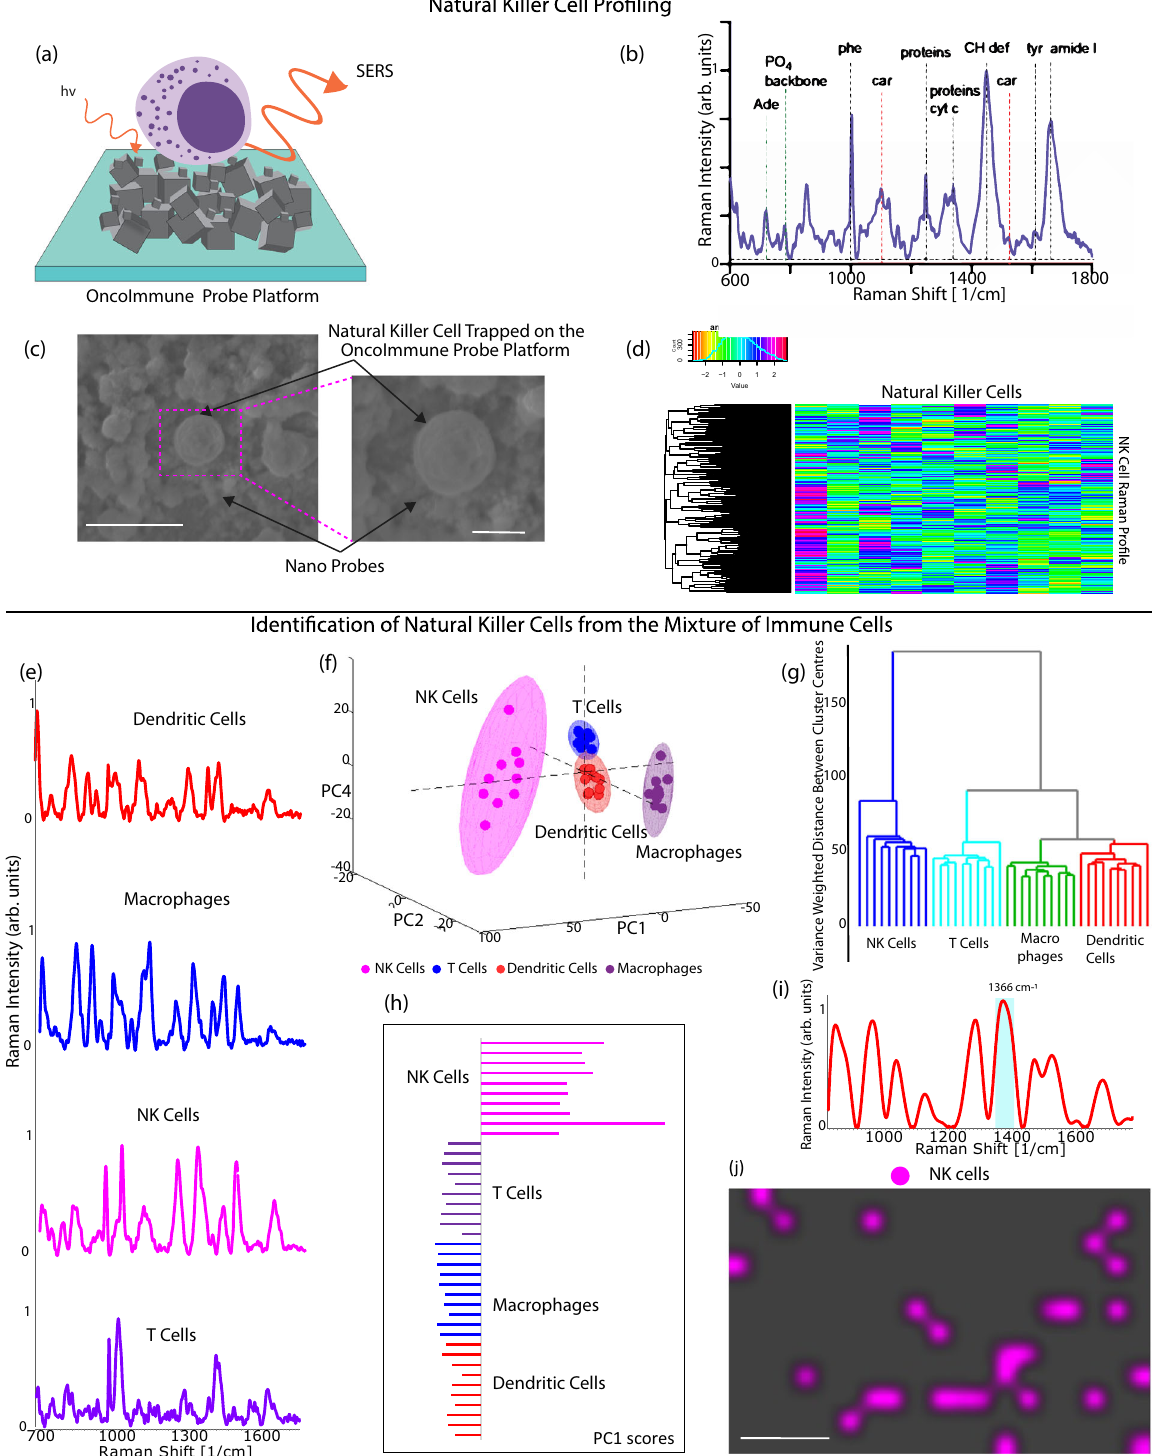
Fig. 4 | Immune cell pro fi ling for cancer diagnosis. Circulating natural killer cell pro fi ling (CNKP) using SERS ( a ) Schematic representation of NK Cell on OncoIm- mune probe platform ( b ) Representative Raman spectraof NK cell demonstrating presence of various biomolecules of NK cells ( c ) SEM image of NK cell trapped on the OncoImmune probe platform. Scale bar = 3 um and 1um respectively ( d ) Heatmap of the holistic Raman pro fi le of NK cells demonstrating correlated cel- lularbiomolecules. Identi fi cation of NKcellsfrom the mixed population ofPBMCs ( e )RepresentativeRamanspectraof varioustypesofPBMCs — dendriticcells(red),